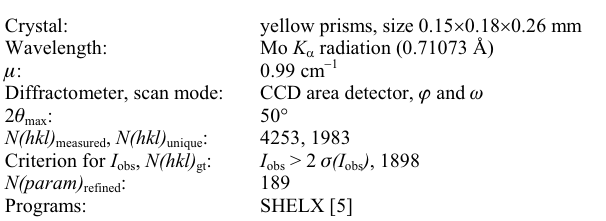
Table 1. Data collection and handling.